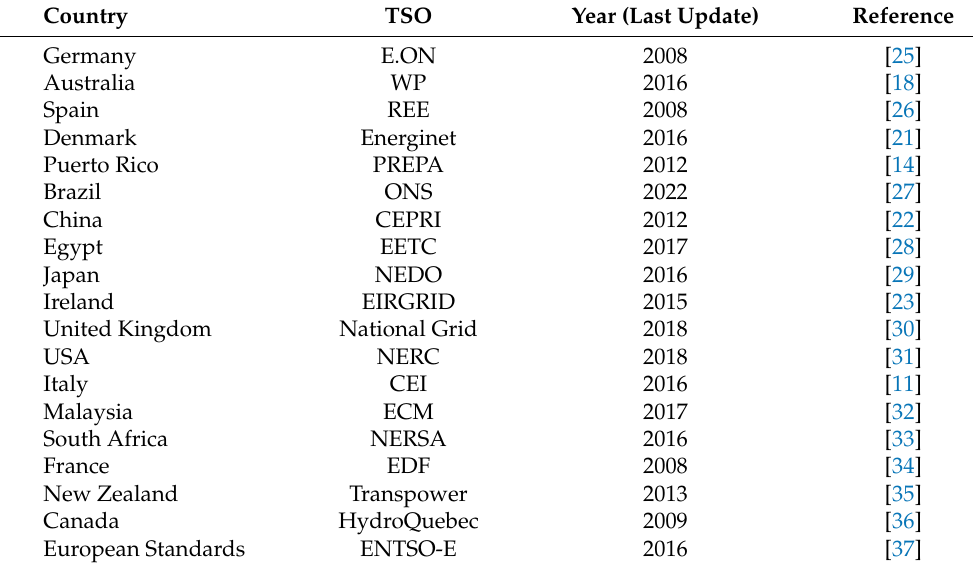
Table 1. Grid codes of different countries and their transmission system